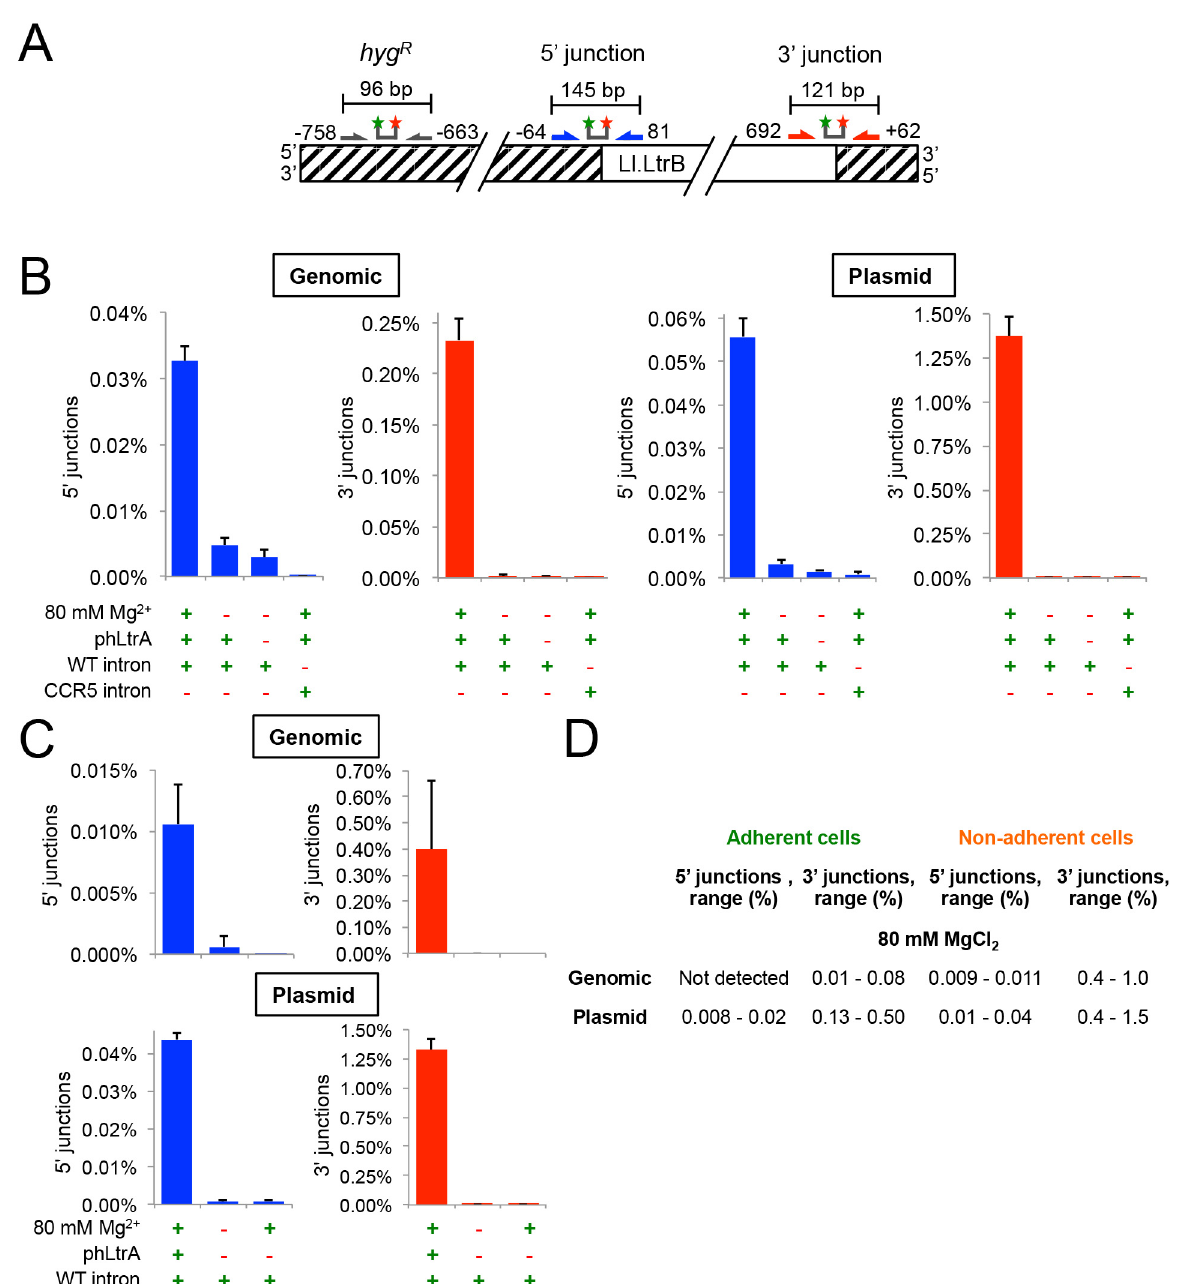
Fig 5. The group II intron Ll.LtrB can retrohome into genomic and plasmid target sites in human cells after addition of Mg 2+ to the cell culture medium. (A) Diagram of Taqman qPCR assays used to measure retrohoming efficiency. The wild-type Ll.LtrB target site was inserted into the genome of HEK-293 Flp-In cells and cloned in recipient plasmid pFRT for assays of genomic and plasmid retrohoming, respectively. Striped regions indicate DNA from the plasmid used in generating the Flp-In cell line. Arrows and starred bars indicate primers and Taqman probes used for qPCR, respectively. Green and red stars of Taqman probes correspond to fluorophore and quencher moieties, respectively. Frequencies of 5 ’ - and 3 ’ -integration junctions were measured relative to number of copies of the hygromycin-resistance marker ( hyg R ) present upstream of the Ll.LtrB target site. (B) and (C) Taqman qPCR assays. HEK- 293 Flp-In cells containing the integrated Ll.LtrB target site were transfected with Ll.LtrB expression plasmids plus recipient plasmid pFRT for plasmid assays, as indicated below the bar graphs, and incubated in culture medium supplemented with 80 mM MgCl 2 for 24 h, prior to recovering total cells (adherent and non-adherent) and isolating total DNA for qPCR assays. Blue and red bars show frequencies of 5 ’ - and 3 ’ -integration junctions (note different scales), respectively, relative to copies of a sequence within the hyg R marker. The bar graphs show the average for three experiments with the error bars indicating the SD. (D) Retrohoming frequencies in adherent versus non-adherent cells after 24 h with 80 mM MgCl 2 added to the culture medium. The values